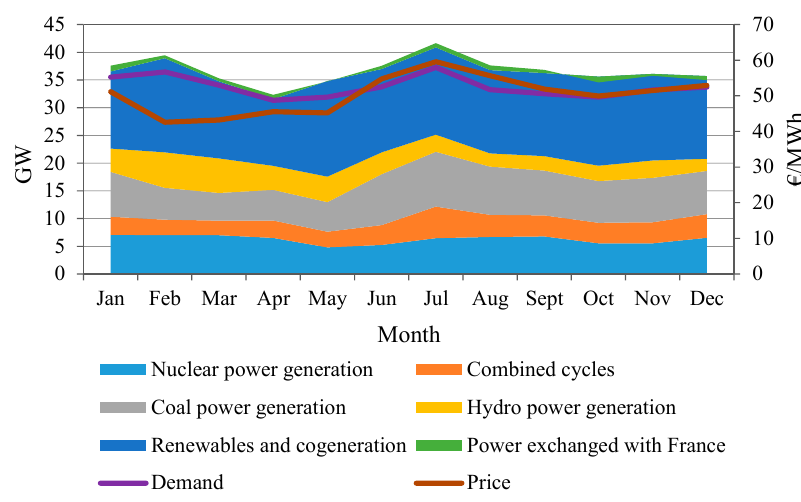
Figure 1. Monthly electricity generation, demand and real price of electricity in 2015. Energies 2018 , 11 , x